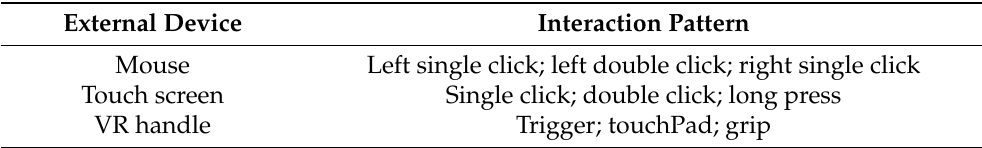
Table 3. The interaction pattern of external devices.